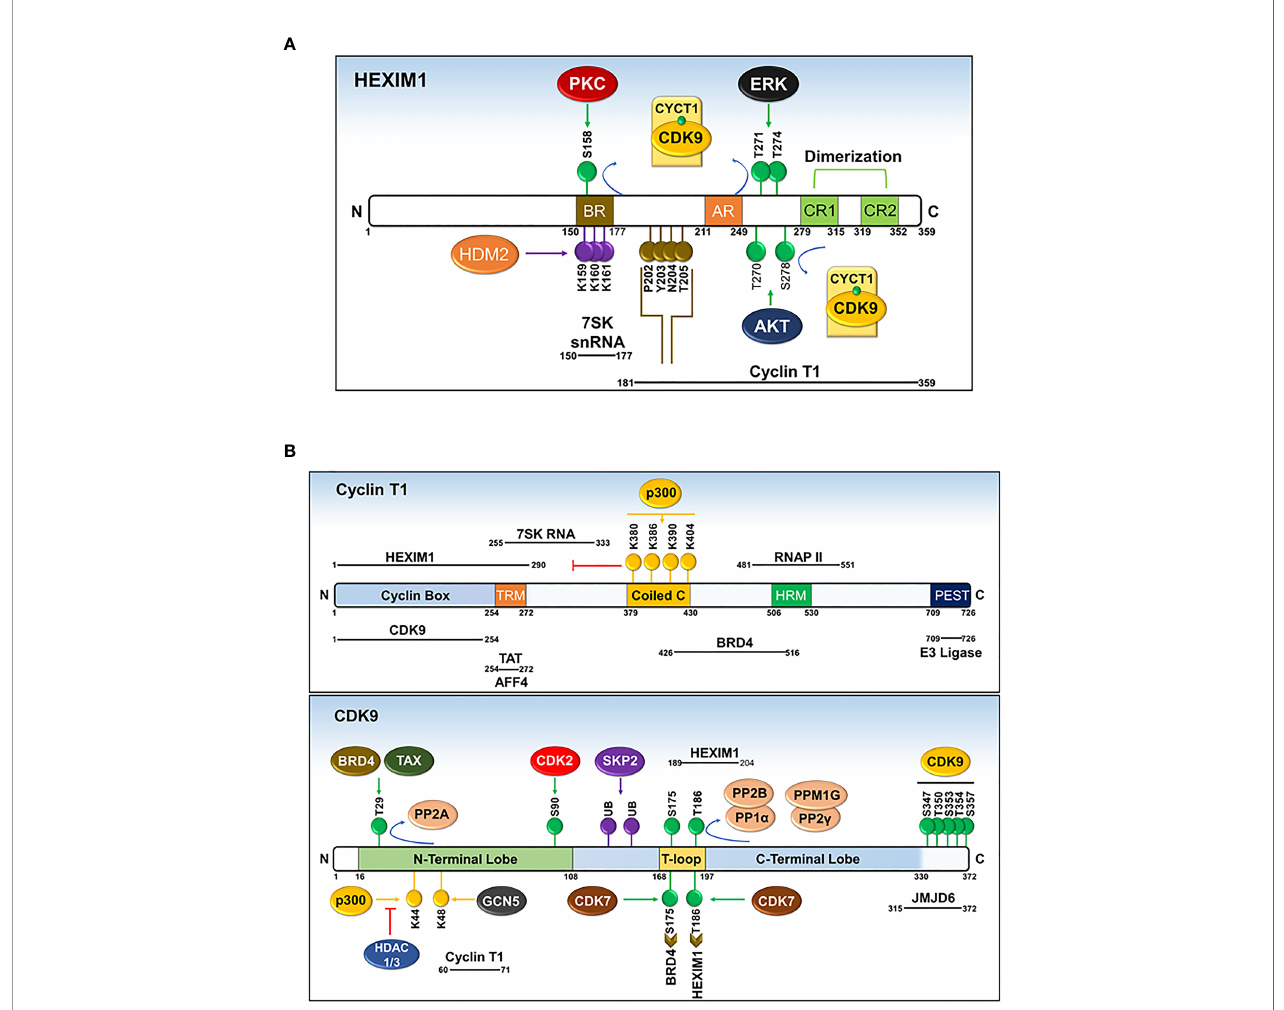
FIGURE 7 | Domains and post-translational modi fi cations of HEXIM1 (A) , cyclin T1 (B) , and CDK9 (B) . Phosphorylated (green), ubiquitinated (purple), acetylated (yellow), and PYNT (brown) motifs are shown. Numbers indicate the positions of amino acid residues. BR, basic region; AR, acidic region, encompassing AR1 and AR2; CR, coiled-coil region. Solid black lines with indicated spans of amino acid residues indicate the regions responsible for interactions with other binding partners. Modi fi ed from Cho, Schroeder and Ott, Cell Cycle, 9 (9), 1697-1705